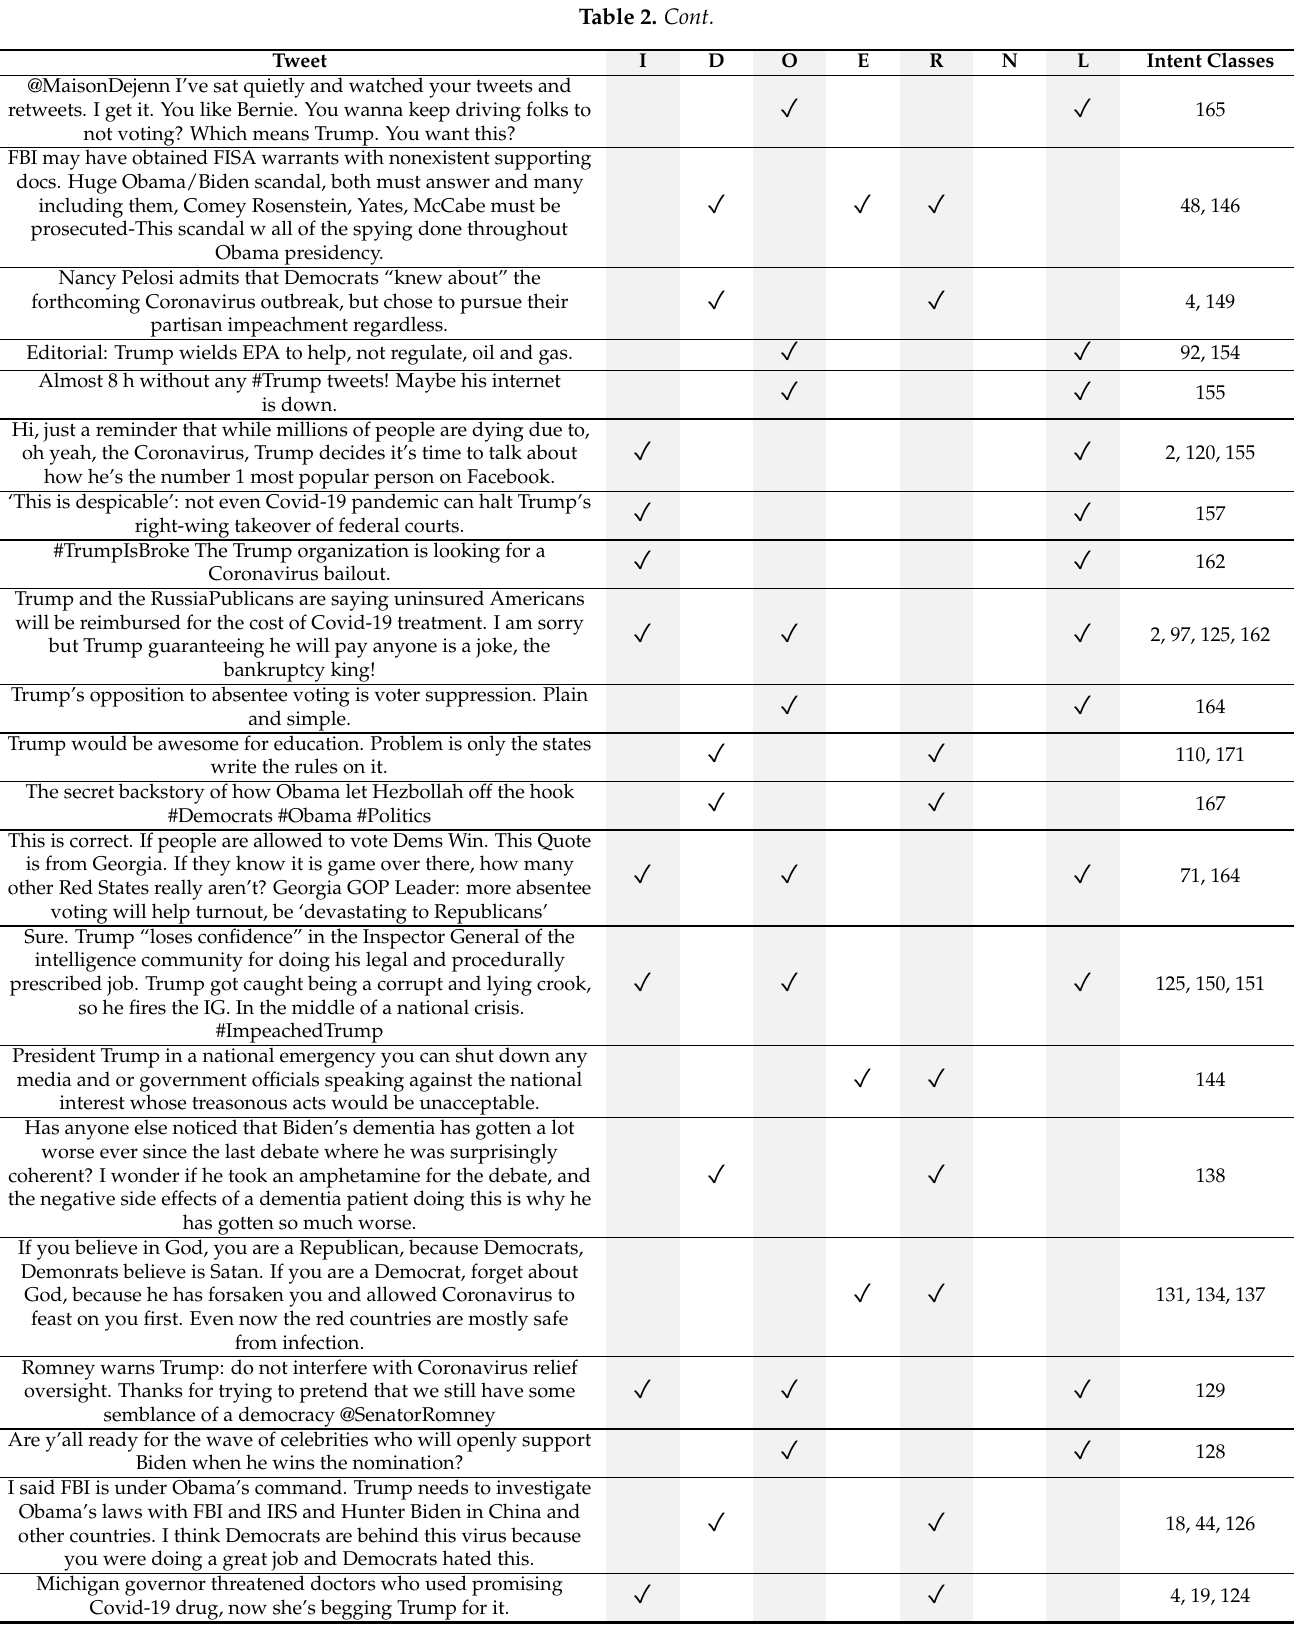
Table 2. Example Tweets and their classes: I stands for information, D for disinformation, O for opinion, E for extreme opinion, R for rightist, N for neutral, and L for leftist.